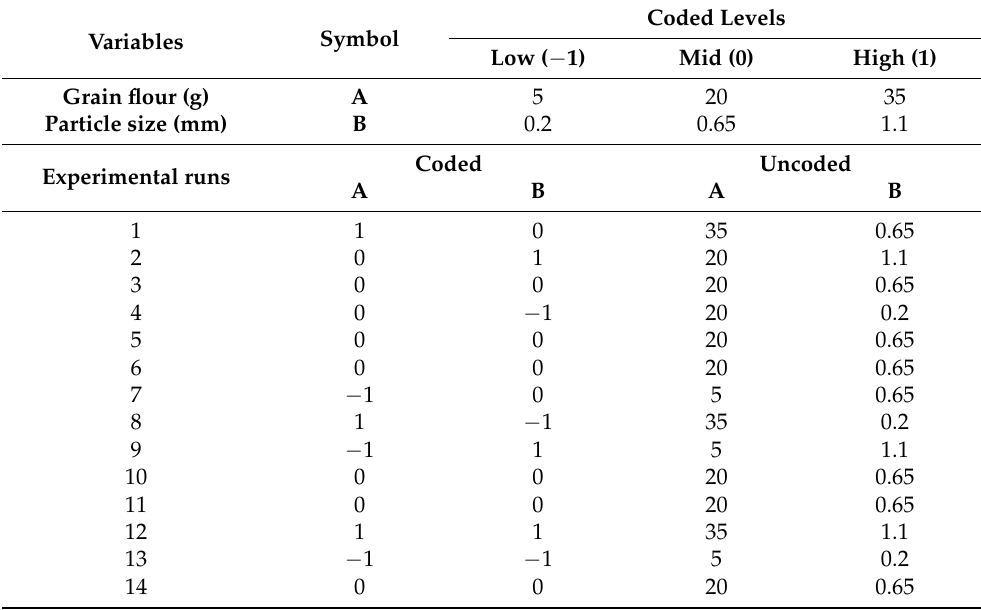
Table 1. Experimental ranges of the two variables studied, grain flour and particle size, using response surface methods, a central composite design in terms of actual and coded variables, alongside the experimental runs that were carried out during the trial, which were conducted in